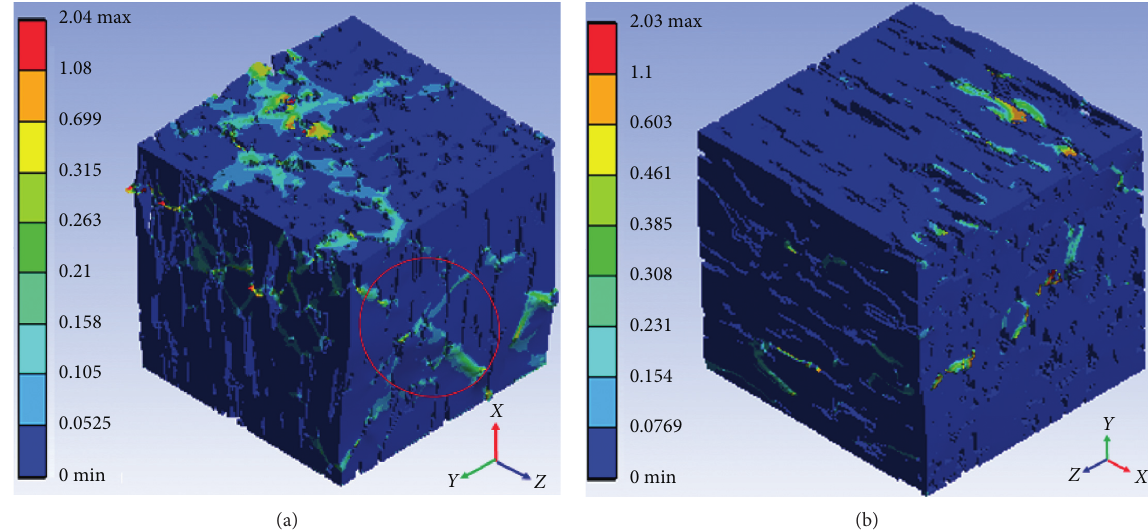
Figure 10: Plastic stain distribution of model S2 represents the loading applied (a) in X direction and (b) in Y